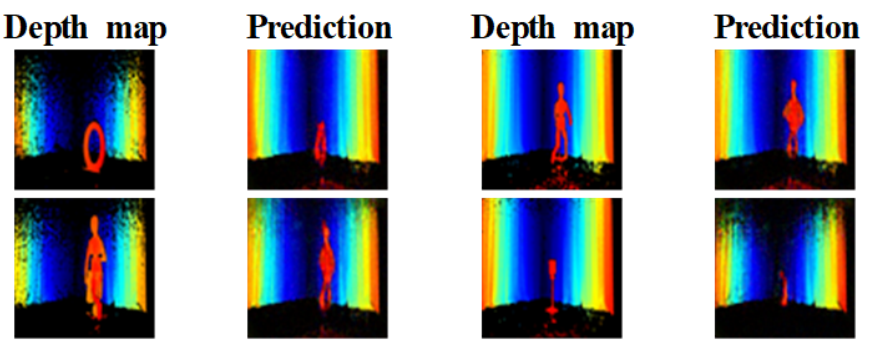
Figure 11. Depth prediction using data not included in the training